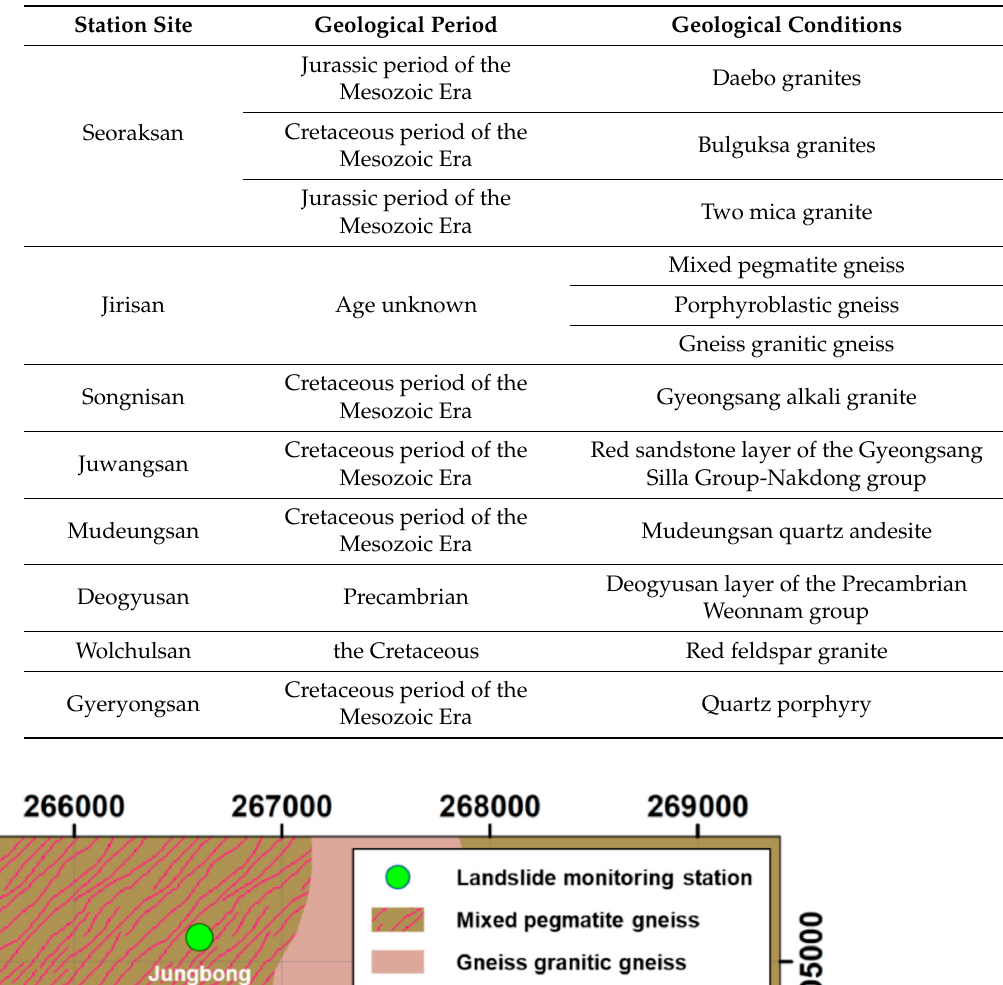
Table 3. Geological conditions of the landslide monitoring station locations.